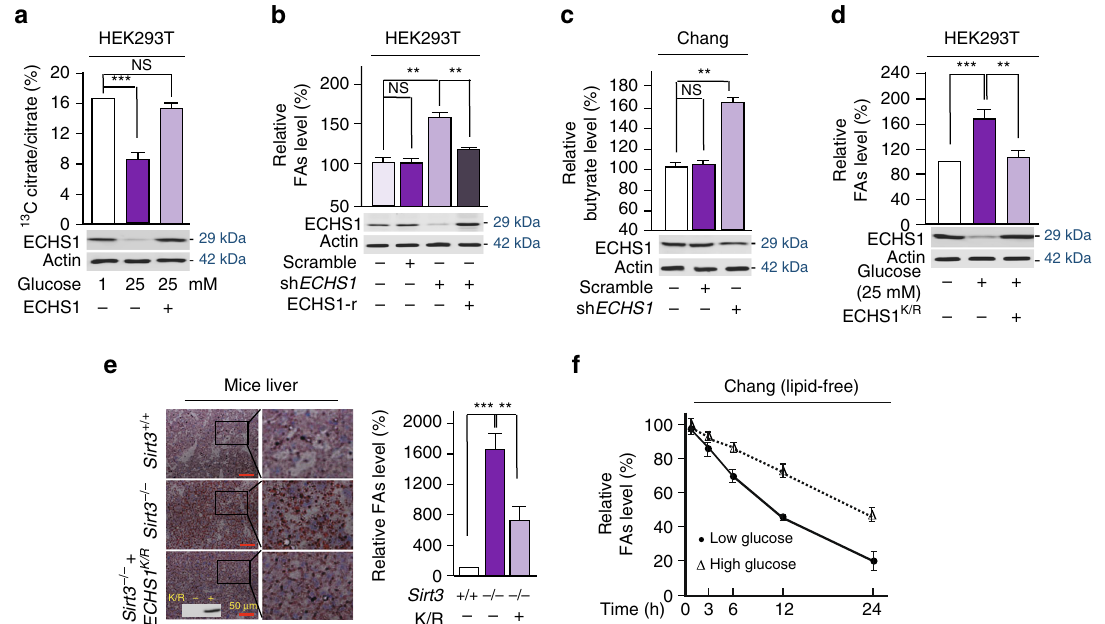
Fig. 8 Nutrient induces FAs accumulation. a The conversion of 13 C-palmitate to 13 C-citrate was traced in HEK293T cells cultured in low and high glucose media, and in ECHS1 overexpressing HEK293T cells cultured in high glucose media. b Relative FAs levels in HEK293T cells, ECHS1 knocked down HEK293T cells and ECHS1 knocked down HEK293T cells overexpressing shRNA resistant ECHS1 (ECHS1-r) were detected. All levels were normalized to the total proteins. c The relative butyrate levels in Chang liver cells and ECHS1 knocked down Chang liver cells were determined ( n = 4). The butyrate levels in untreated Chang liver cells (25 μ M) were set as 100%. d The relative FAs levels in HEK293T cells cultured in low glucose ( − ), high glucose (+), and high glucose with ECHS1 K101R overexpression were determined ( n = 3). e The FAs levels in the liver of wild type, Sirt3 − / − , and ECHS1 K/R overexpressing Sirt3 − / − 129/C57BL6 mice were assessed by oil red staining. Four mice of each group were analyzed. Relative FAs levels were determined by comparing intensity of signals, Sirt3 + / + value was set as 100% arbitrarily ( right ). f The relative (to time 0) intracellular FAs levels in Chang cells that were maintained in high glucose (25 mM) and low glucose (1 mM) were detected ( n = 3) at time points as indicated. For all fi gures, mean values with SD are reported. NS not signi fi cant; * P < 0.05; ** P < 0.01; *** P <